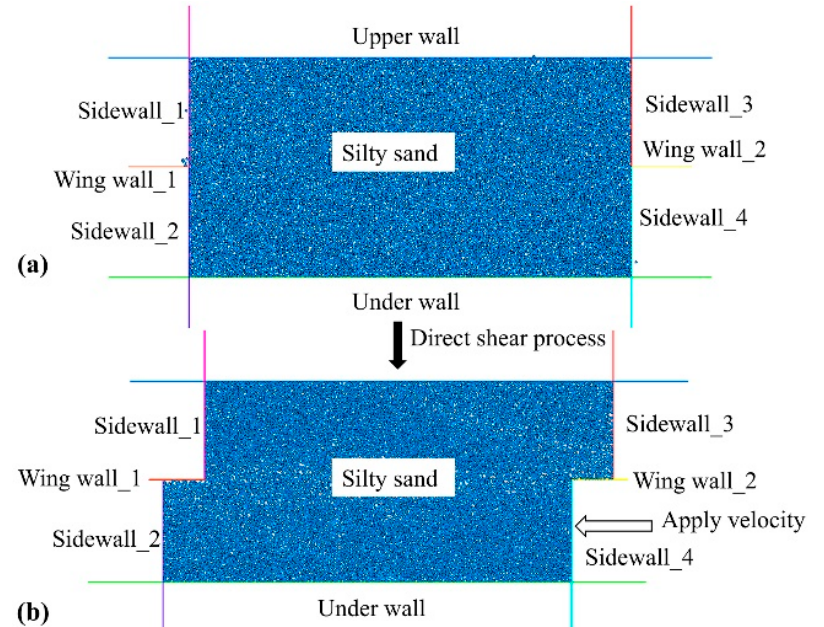
Figure 4. Two states of the direct shear test in two-dimension DEM of silty sand: ( a ) Initial state; ( b ) Final state.